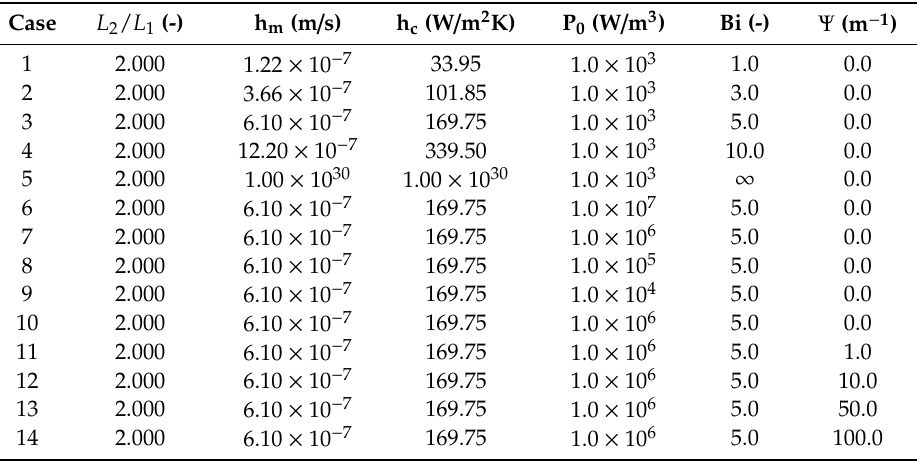
Table 1. Parameters used in the simulations for the microwave drying and